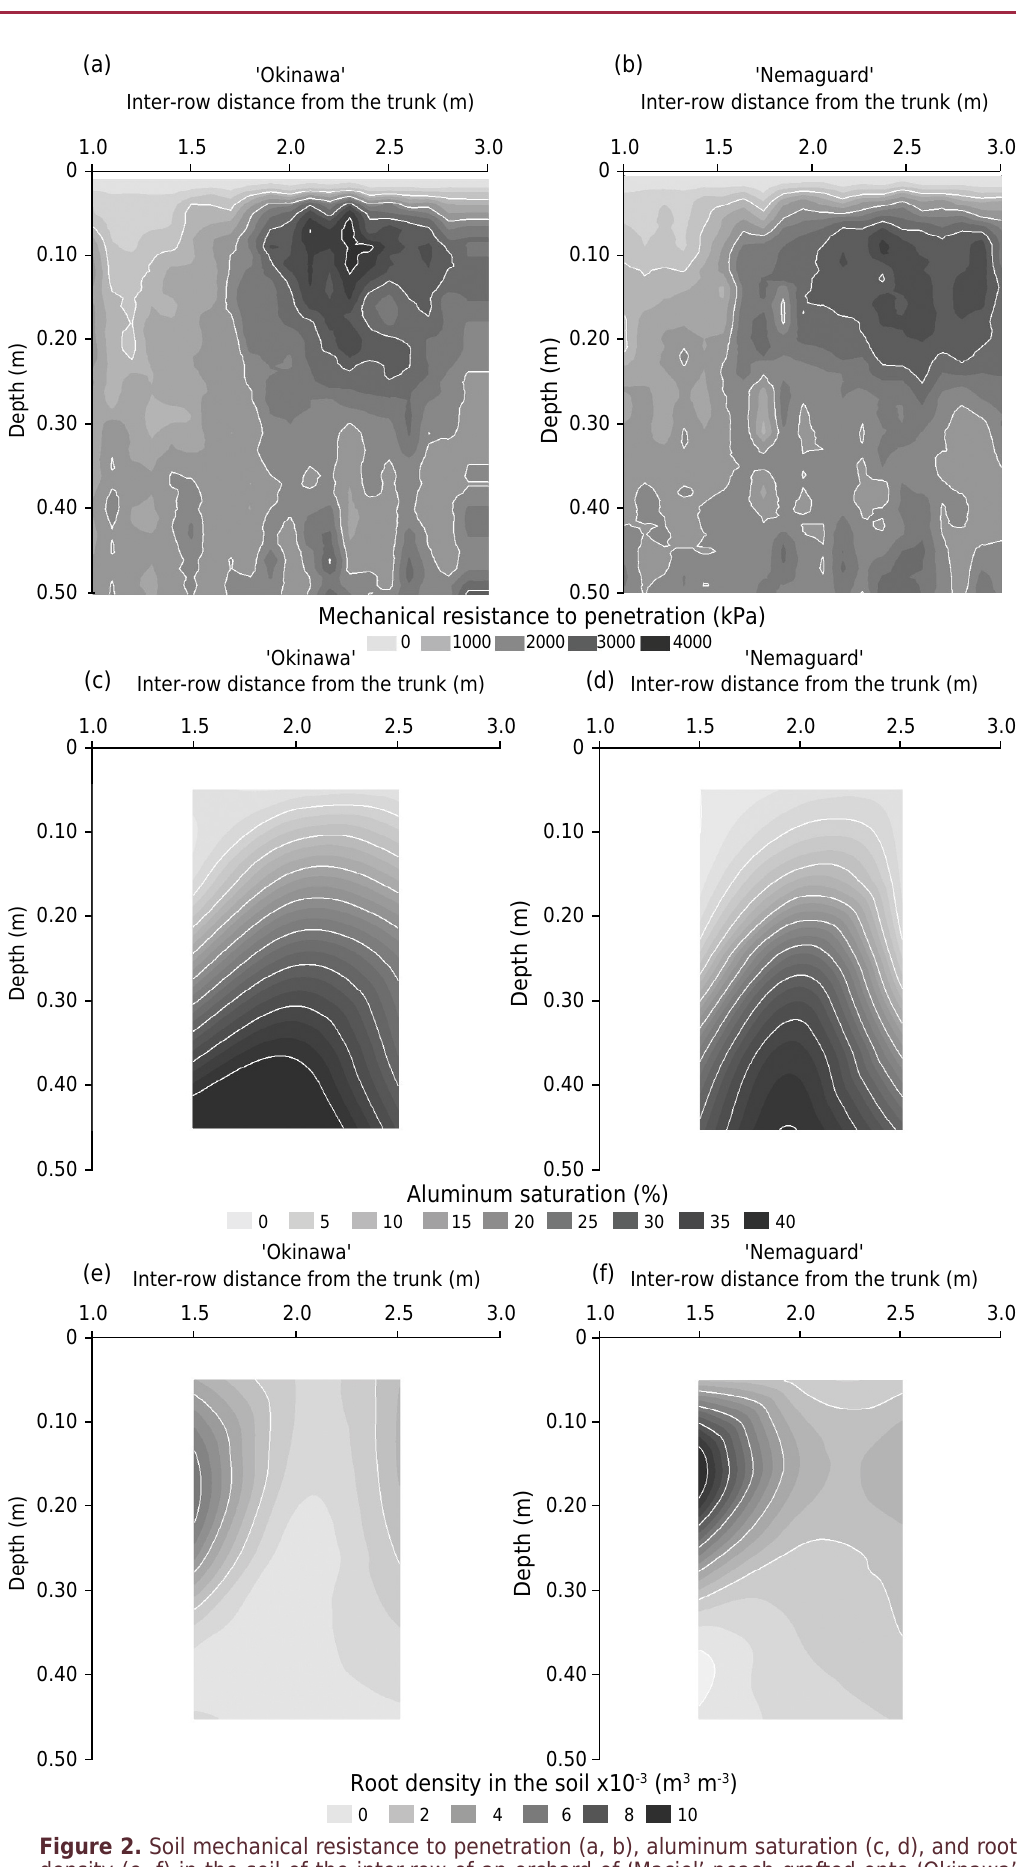
Figure 2. Soil mechanical resistance to penetration (a, b), aluminum saturation (c, d), and root density (e, f) in the soil of the inter-row of an orchard of ‘Maciel’ peach grafted onto ‘Okinawa’ and ‘Nemaguard’,